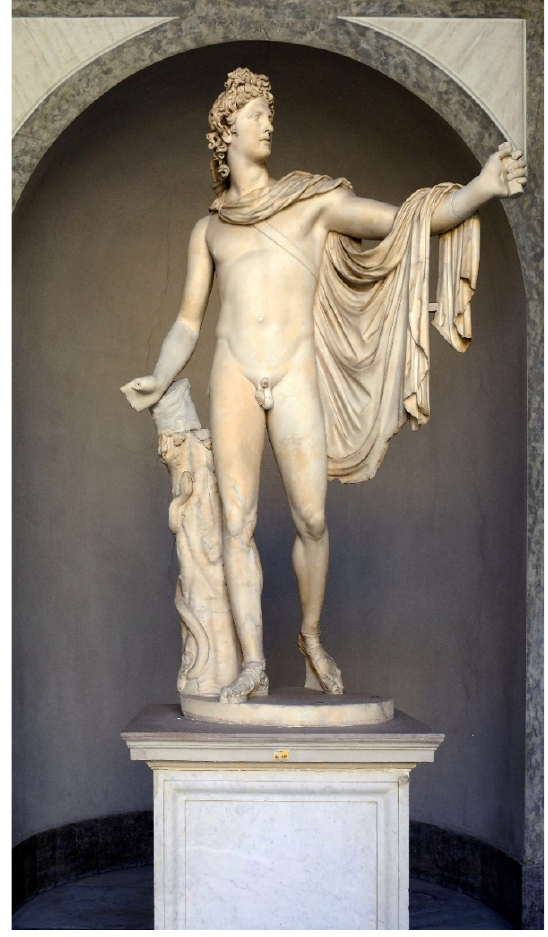
Figure 4. Apollo Belvedere . Belvedere Court, Rome.